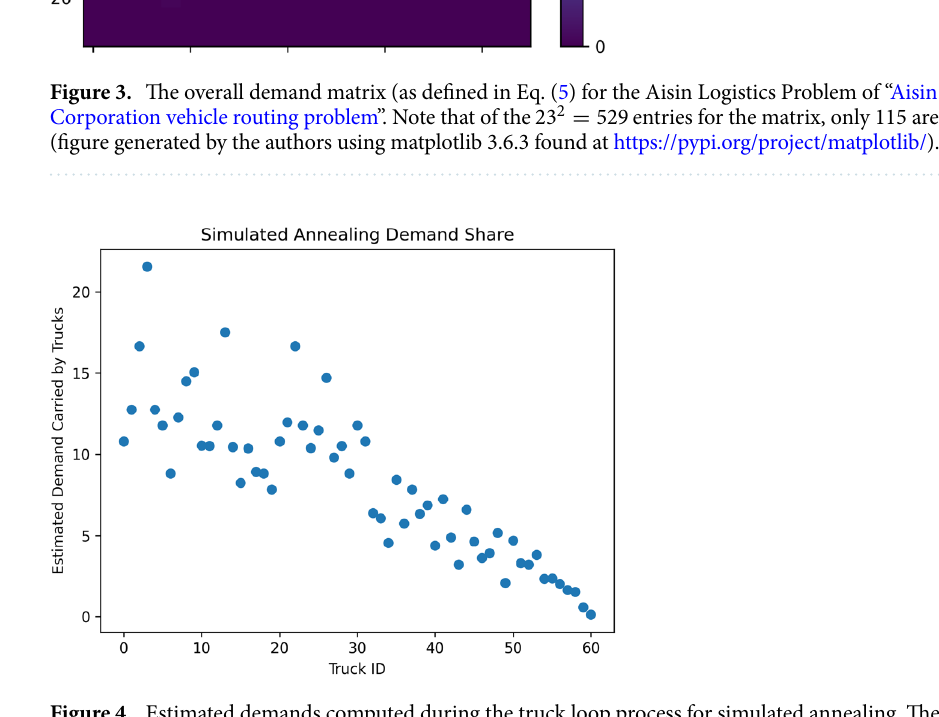
Figure 4. Estimated demands computed during the truck loop process for simulated annealing. The algorithm terminated after 61 trucks were given routes. Demands are estimated by the method explained in “Supply chain